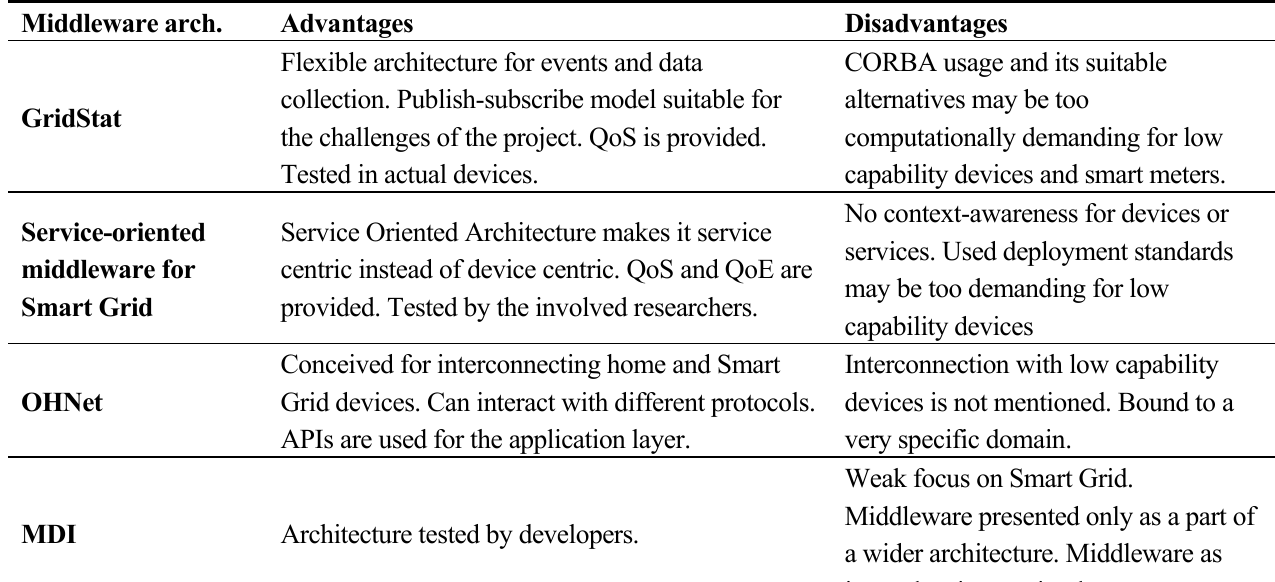
Table 13. Main advantages and disadvantages of middleware architectures for Smart Grids Middleware